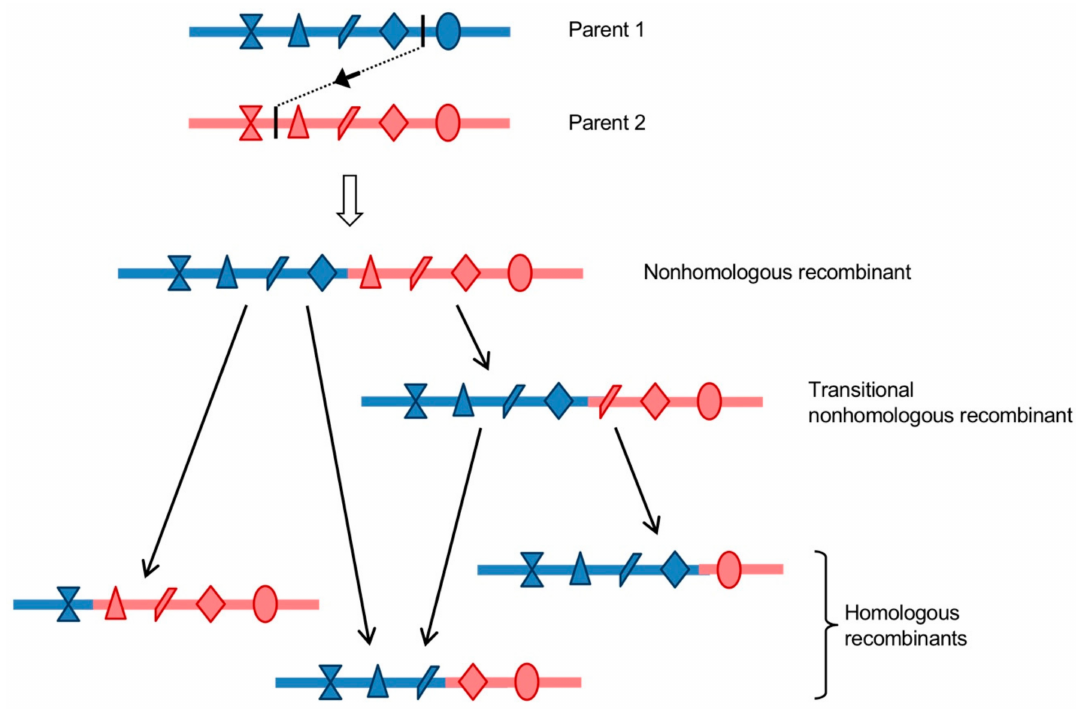
Figure 6. Model of generation of homologous recombinants from a nonhomologous one. A nonhomologous recombinant genome, displaying a duplication of homologous sequences around the recombination site, is produced by a replicative or nonreplicative recombination mechanism. Icons represent di ff erences between the two homologous parental genomes. During the following replication cycles, the nonhomologous recombinant genome can generate a series of homologous recombinants through one or more rearrangement event(s). Recombination and rearrangement may take place within the initial co-infected (or co-transfected) cell, or in a di ff erent cell following re-infection, supposing that the nonhomologous recombinant can be encapsidated